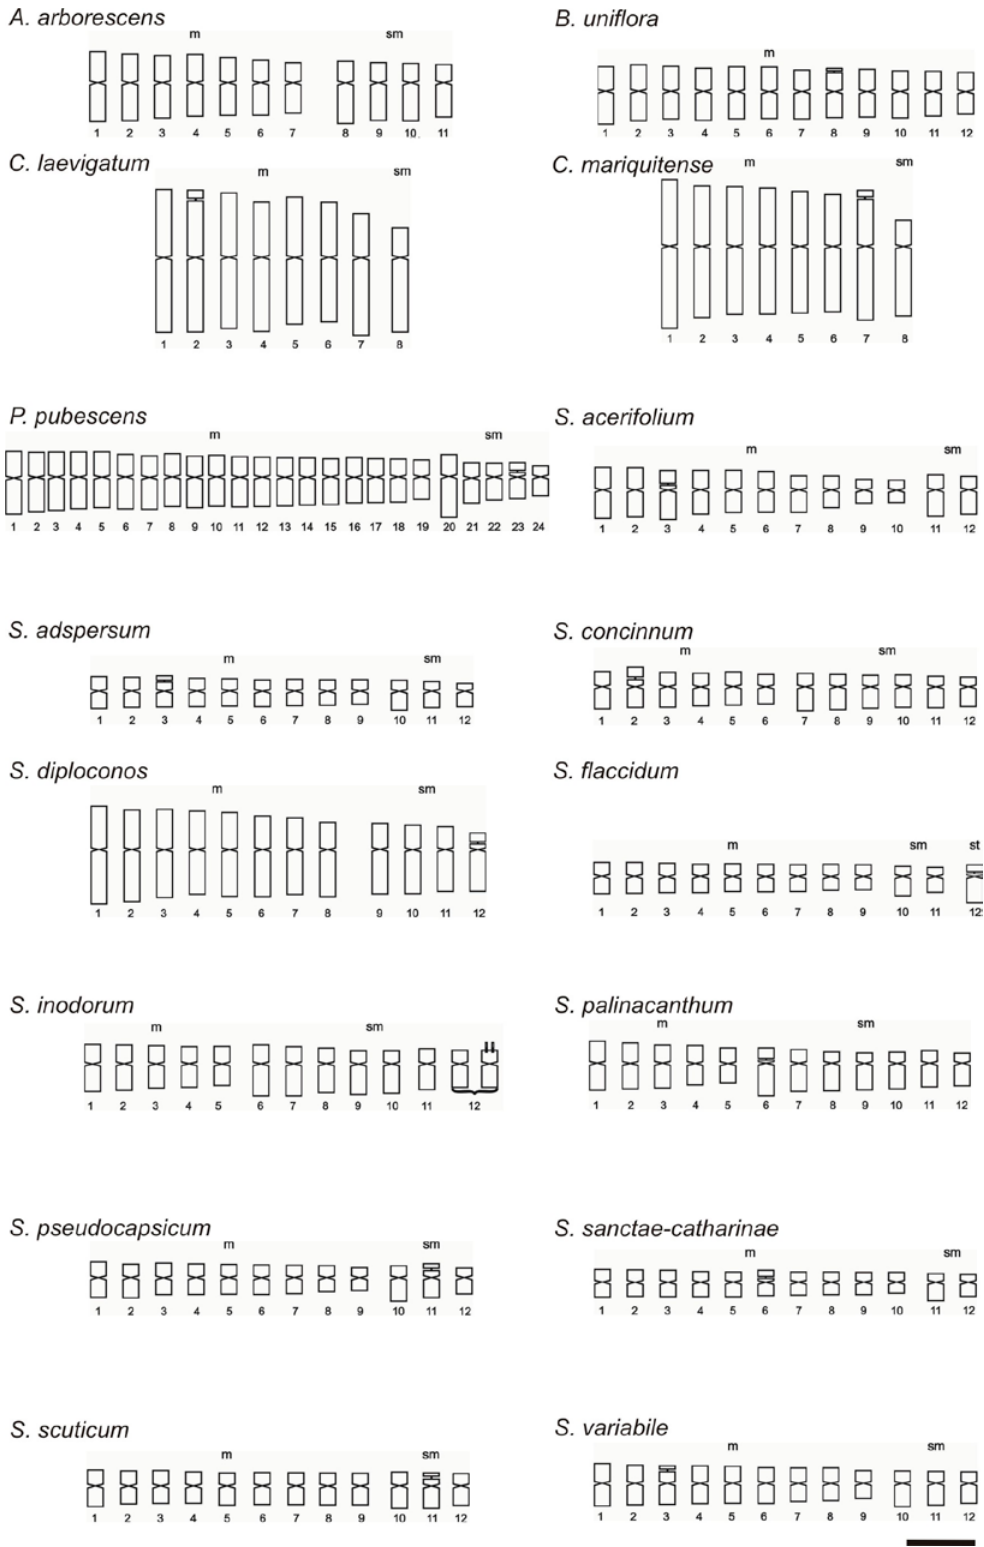
Fig. 3. Ideograms of the investigated Solanaceae species based on median chromosome values. Bar=5